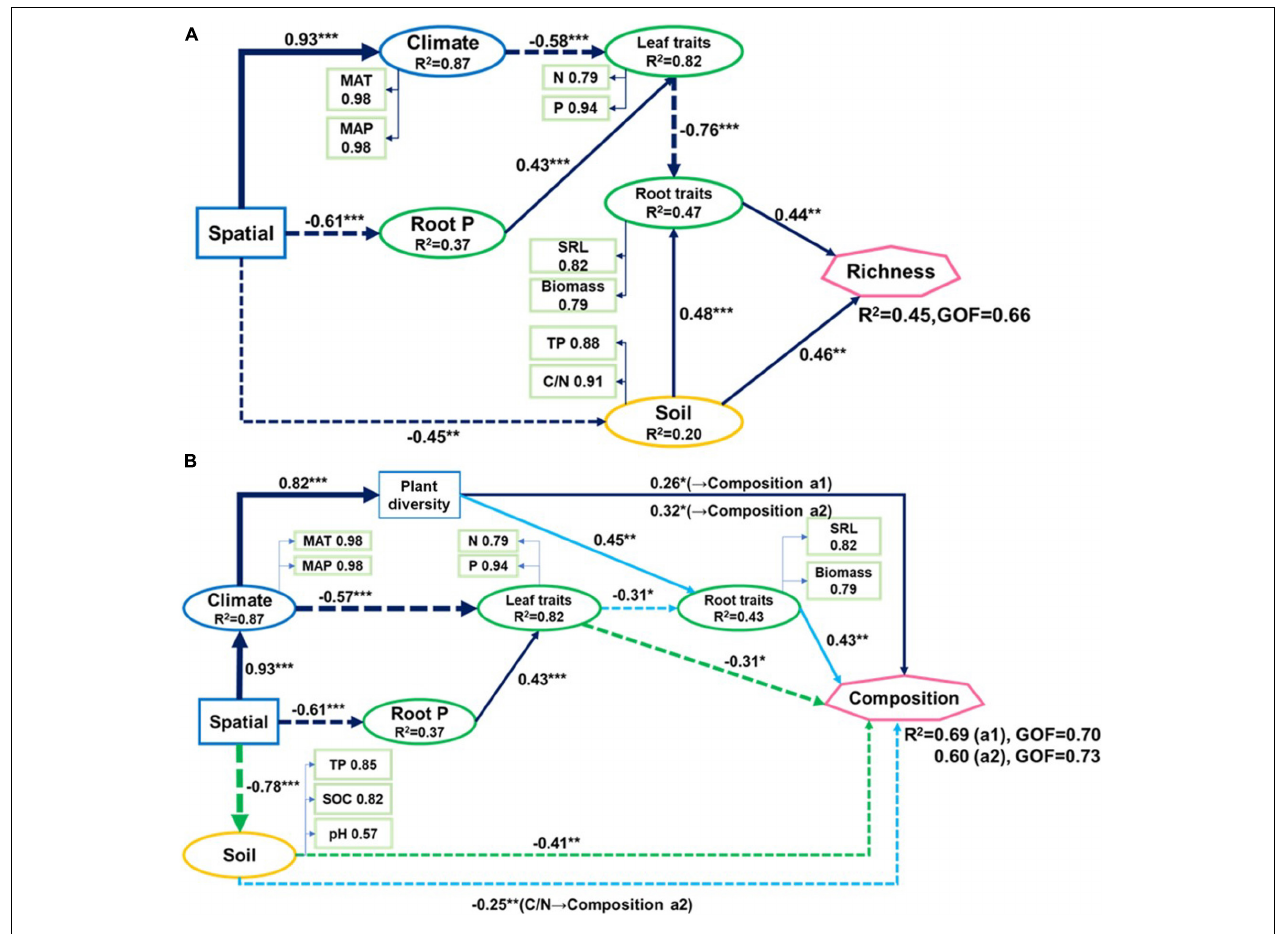
FIGURE 4 | Partial least-squares path models showing (A) relationships of fungal richness and (B) community composition (two axes from non-metric multidimensional scaling) with climatic and spatial factors, plant traits, and soil properties of nine forest ecosystems. The solid line represents a positive correlation, the dotted line represents a negative correlation. Green line in (B) indicates paths to composition a1. Blue line indicates paths to composition a2. Black line indicates paths common to compositions a1 and a2. GOF: goodness-of-fit. Arrow widths are proportional to strengths of causal relationships supplemented by standardized path coefficients (* p < 0.05; ** p < 0.01; *** p < 0.001). R 2 indicate explained variances in response